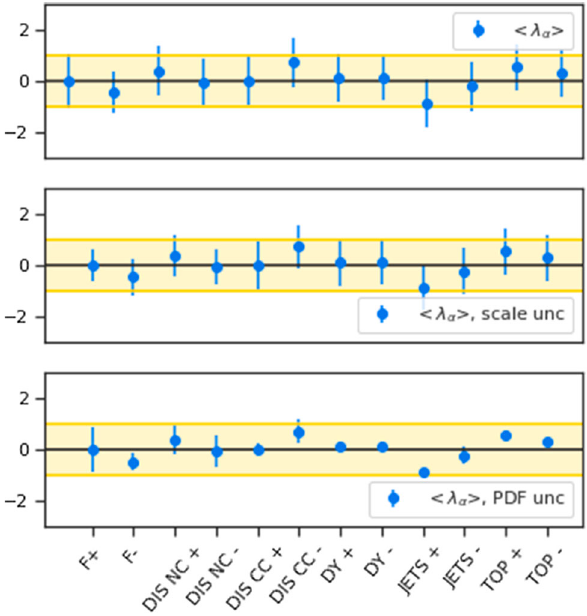
Fig. 5 Nuisance parameters λ for directions in the space of scale vari- ations corresponding to up/down changes in factorization scale, and in renormalization scale for the five types of processes in the determina- tion of the 9-pt theory covariance matrix for MHOU. The uncertainties in the nuisance parameters are shown in total, and broken down into the contribution from scale uncertainties alone and from PDF uncertainties, just as in Fig. 4. The yellow bands highlight the region between ±